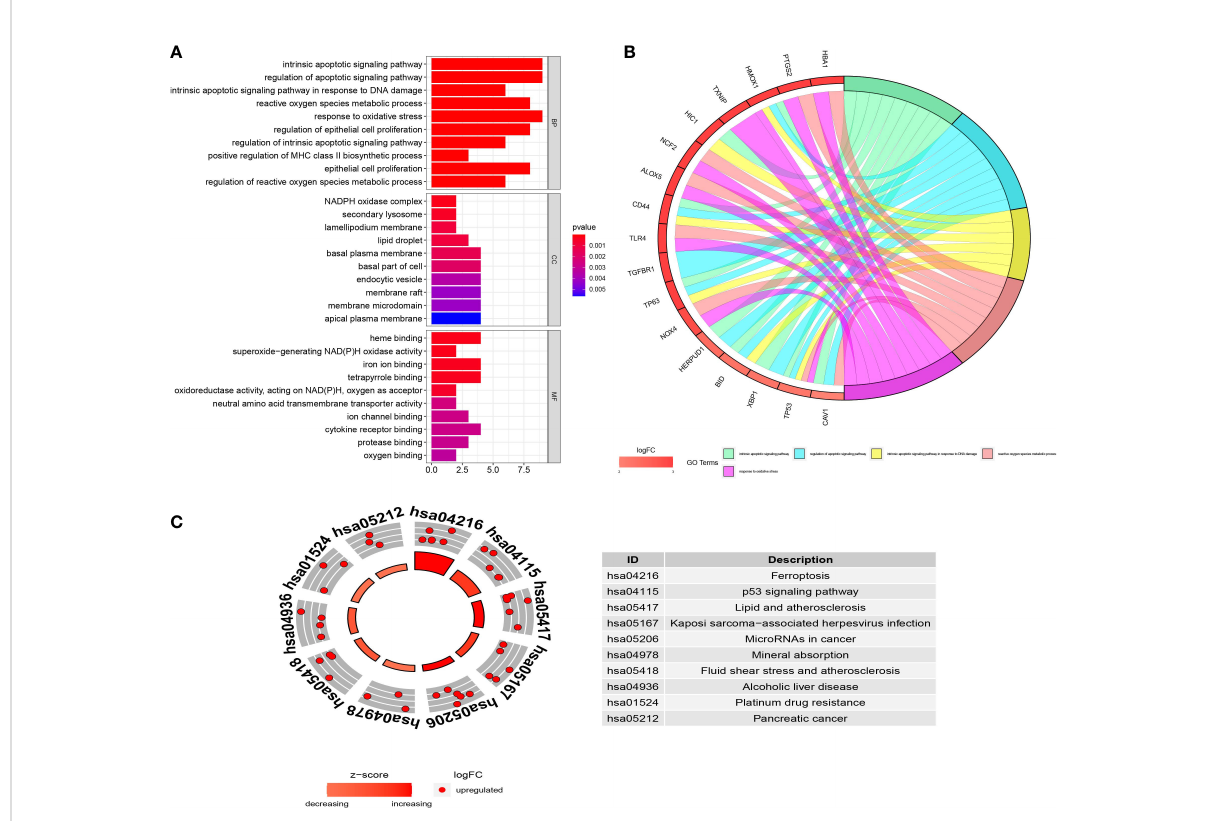
FIGURE 3 The functional enrichment analyses of the ferroptosis-related differentially expressed genes (DEGs). (A) GO analysis of the ferroptosis-related DEGs. (B) Chord plot shows the distribution of ferroptosis-related DEGs in different GO terms. Symbols of ferroptosis-related DEGs are shown on the left side of the plot with their logFC values indicated by color scale. (C) KEGG analysis of the ferroptosis-related DEGs. The inner ring is a bar plot where height displays the signi fi cance of the term, and the outer ring displays scatter plots which indicate the expression levels (logFC) for the genes in each term. BP, biological process; CC, cellular component; MF, molecular function; logFC, log2